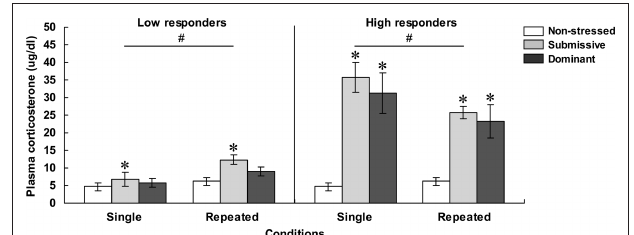
Figure 2 | Plasma corticosterone levels (μg/dl) in non-stressed mice as well as in submissive and dominant mice engaged in a single (single) or three (repeated) aggressive encounters. Data for low corticosterone responders are shown in the left panel, whereas data for high responders are presented in the right panel. The N /group was the same as that described in Figure 1 . Data represents means ± SEM. * p < 0.05 relative to non-stressed mice. # p < 0.05 relative to the single